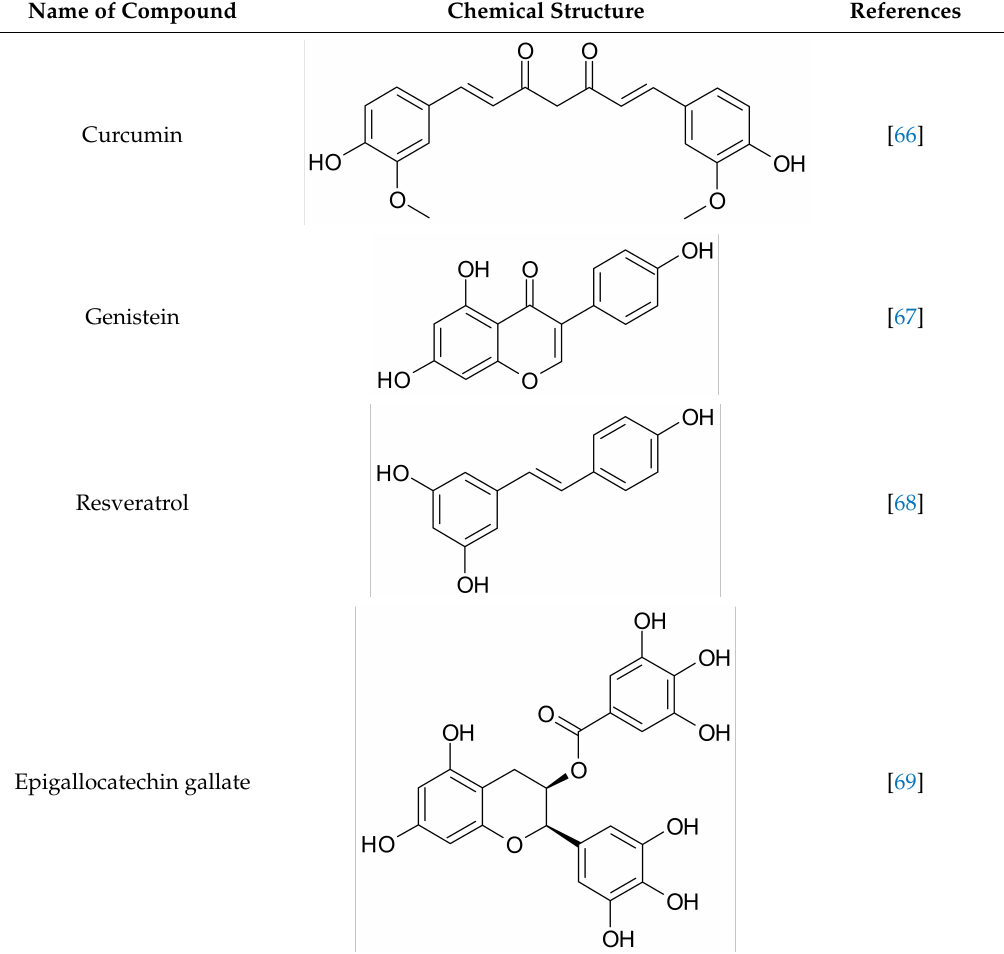
Table 2. Chemical structures of natural compounds in breast cancer prevention.